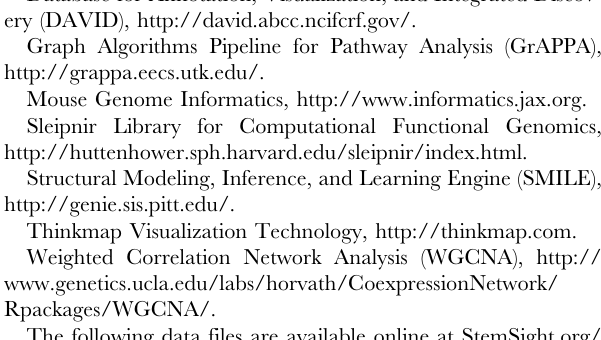
Table S10 Gold Standard Posterior Edge Weight and Rank Order. Table S11 Datasets Supporting Top Ranked mESC Network Edges. Table S12 Protein Coding Gene List. Table S13 mESC Gold Standard Answer